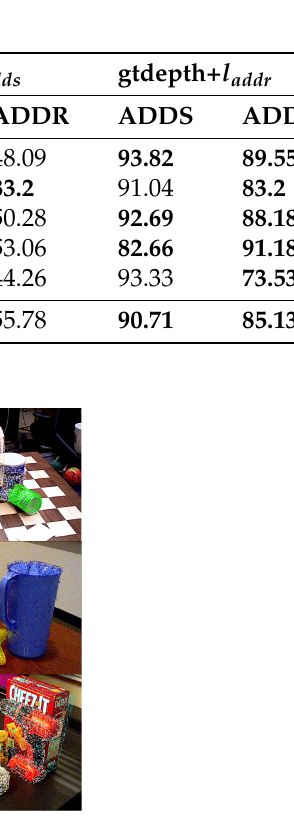
Figure 7. The visualization results of the 6D pose